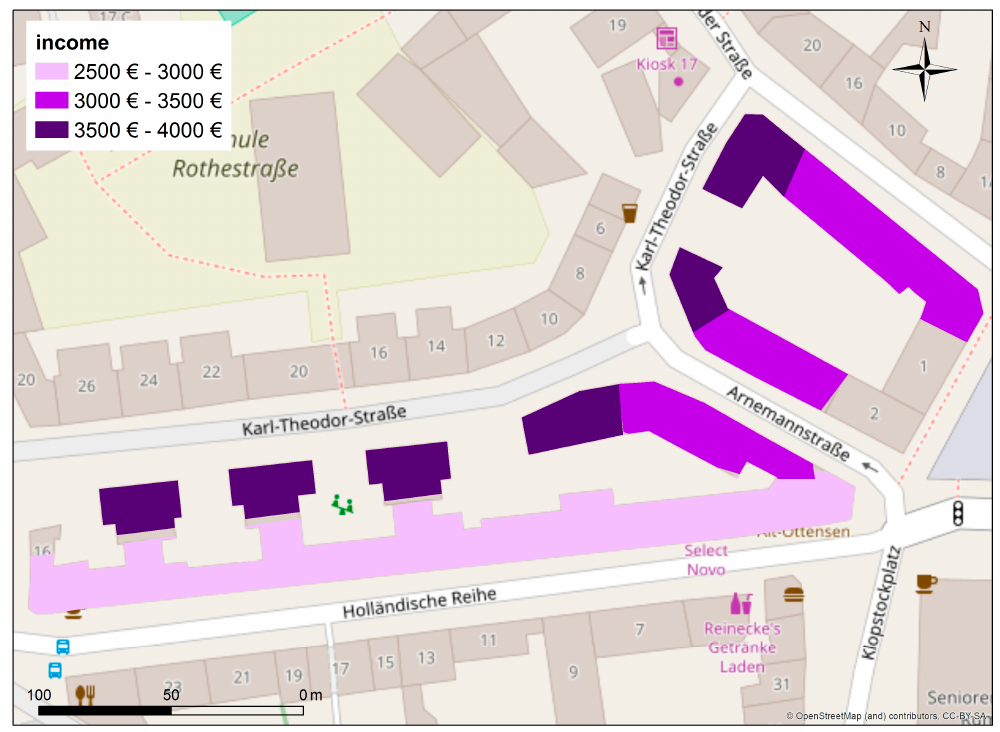
Figure 8. Mean income classes in subarea 6.